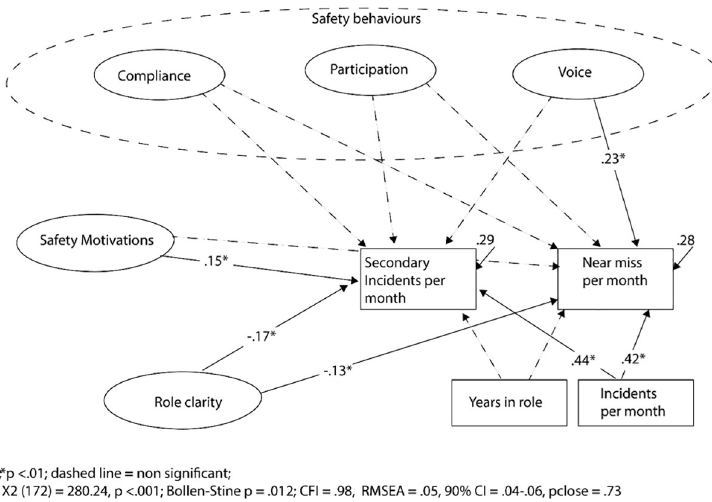
Fig 2. Relationships between safety behaviours, motivations, role clarity and safety outcomes.